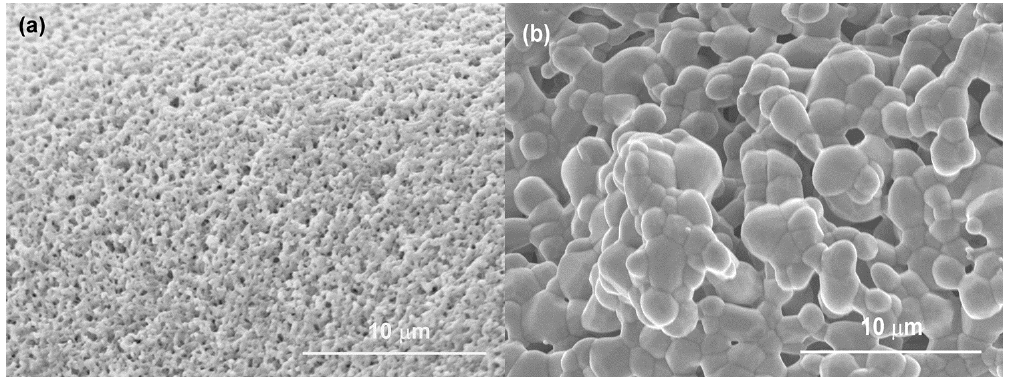
Figure 3. SEM images showing surface morphologies of ( a ) HHA calcined at 720 °C for 5 h; ( b ) CHA calcined at 1100 °C for 3 h.